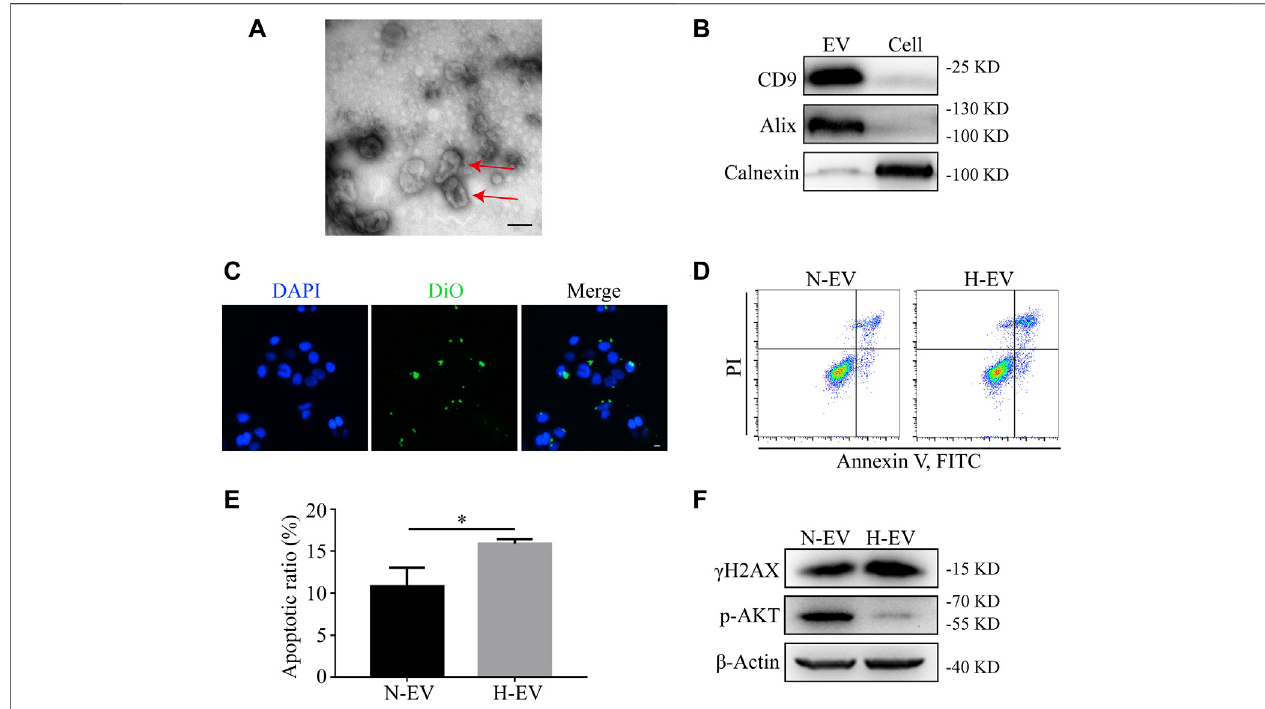
FIGURE 3 | Hypoxic EVs enhance apoptosis in normoxic HIEC cells. (A) Representative TEM image of the saucer-like structures of EVs (red arrow). Scale bar: 100 nm. (B) Western blotting analyzed the EV markers. (C) Representative confocal images showing the uptake of EVs. Scale bar: 10 μ m. (D,E) Flow cytometry investigation ofapoptosis and (F) Western blotting analysis ofthe expression of γ H2AX and p-AKT in HIEC cells given either normoxic or hypoxic EVs. ß -Actin wasused as the internal control. N-EV, normoxic EVs; H-EV, hypoxic EVs. * p < 0.05.